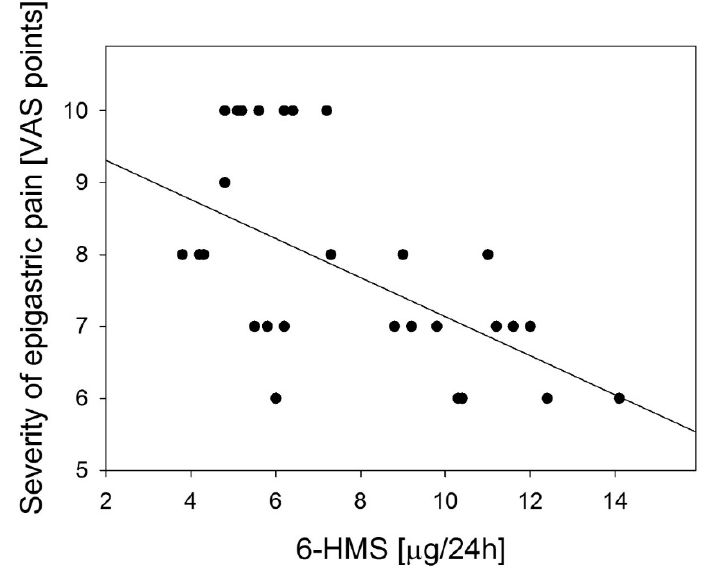
Figure 8. Correlation between urinary 6-hydroxymelatonin sulfate (6-HMS) in body gastric mucosa and the severity of epigastric pain assessed by Visual Analog Scale (VAS) in patients with continuous epigastric pain syndrome ( n = 30). Regression line was calculated by means of the last square method, the R value was equal to − 0.698, p < 0.001.